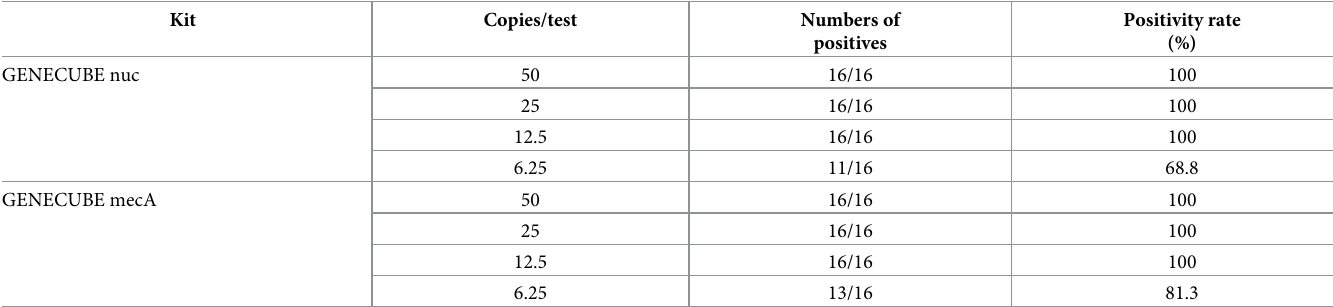
Table 3. Detection limits of GENECUBE nuc and GENECUBE